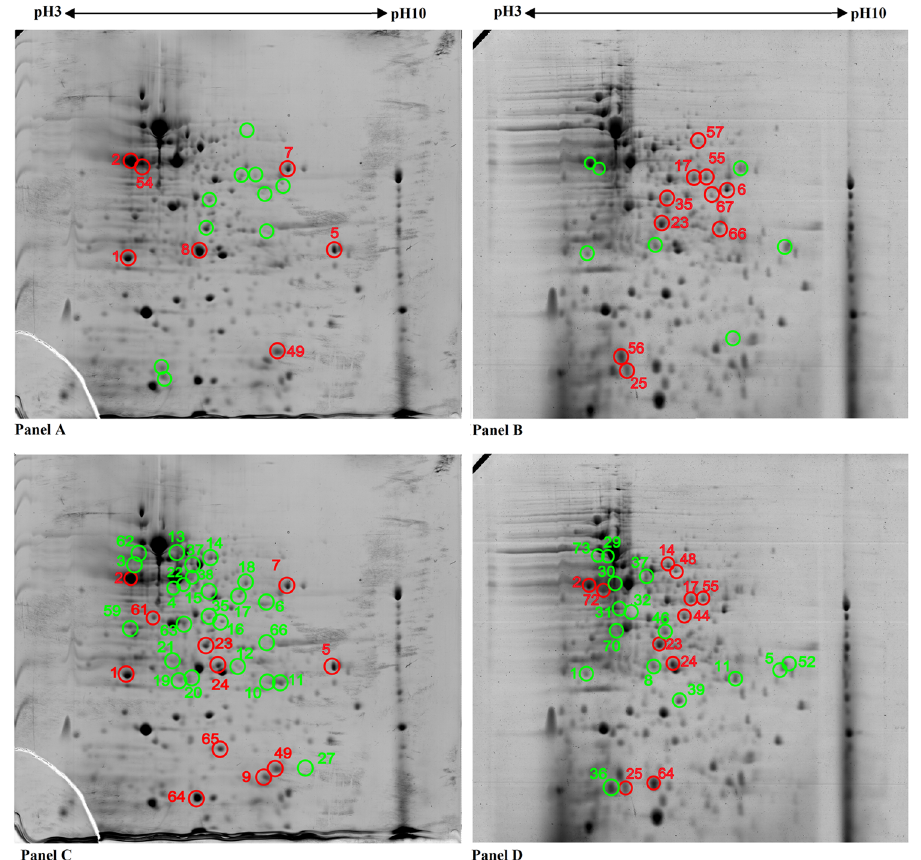
Fig 4. Proteomic profiles of Burkholderia pseudomallei . Regulation of protein spots of SCV post- exposure (Panel B) in comparison with WT post-exposure (Panel A). WT post-exposure gel (Panel C) showing regulation of protein spots in comparison to WT pre-exposure (18) and SCV post-exposure gel (Panel D) showing regulation of protein spots in comparison to SCV pre-exposure (18). In the post-exposure, the bacteria was exposed to A549 cells for 2 hours, then the recovered bacteria were subjected to sonication to lyse the bacteria followed by proteins extraction to be used in 2-D-GE. A total of 550 mg of proteins was separated on an IPG strip pH 3 – 10 in the first dimension, followed by the separation on SDS-12% PAGE for the second-dimension separation. Coomassie blue R-350 stain was used to visualize the separated proteins. The up-regulated protein spots are indicated by red circles and down-regulated spots indicated by green circles. Protein spot numbers relate to information provided in the text and Tables 1 – 3.